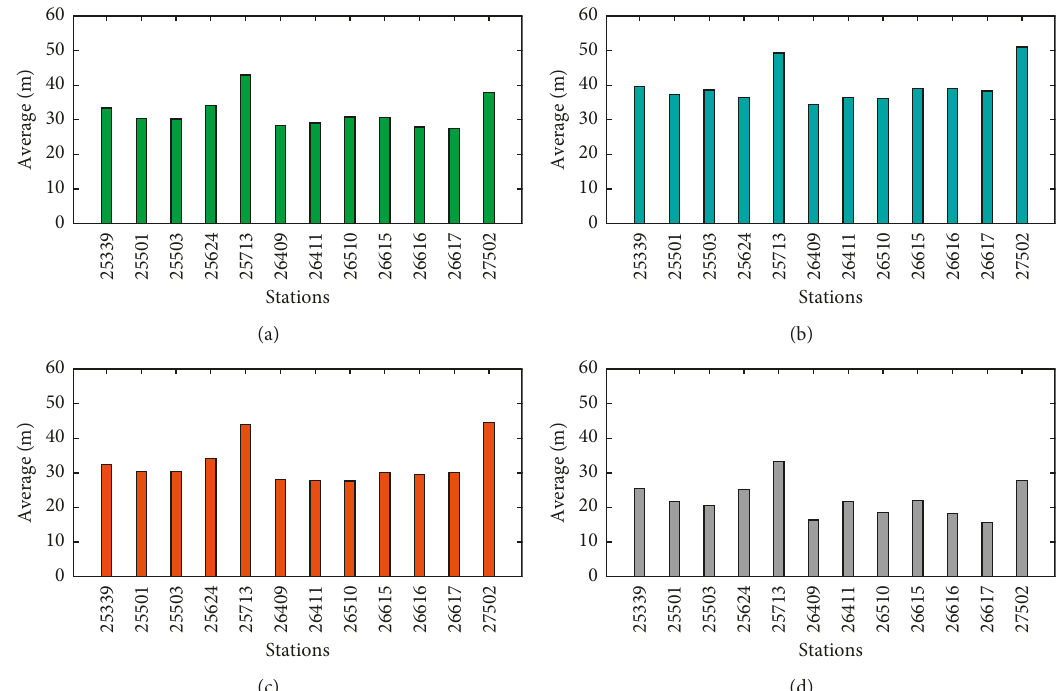
Figure 11: Seasonal average thickness (m) distributions of elevation ducts at 12 stations in Alaska: (a) spring; (b) summer; (c) autumn; (d) winter.